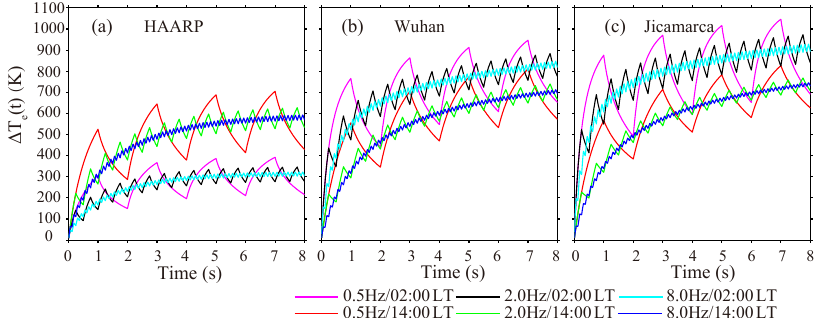
Figure 4. Temporal evolution of electron temperature change at the reflection point.